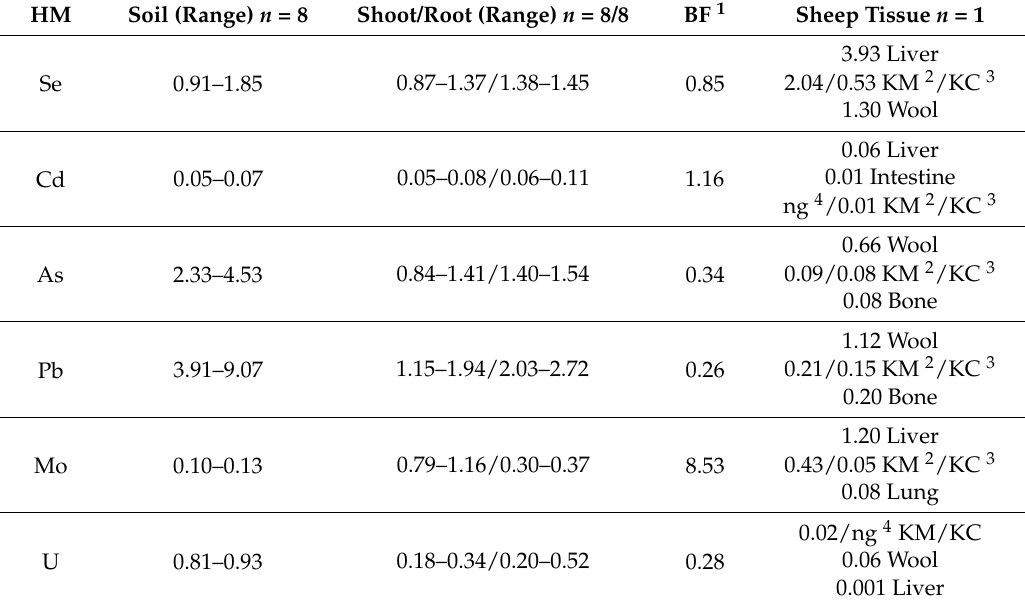
Table 3. Sheep 1 heavy metal concentrations in soil, forage, bioaccumulation factor ratio, and sheep tissue in mg/kg, dry